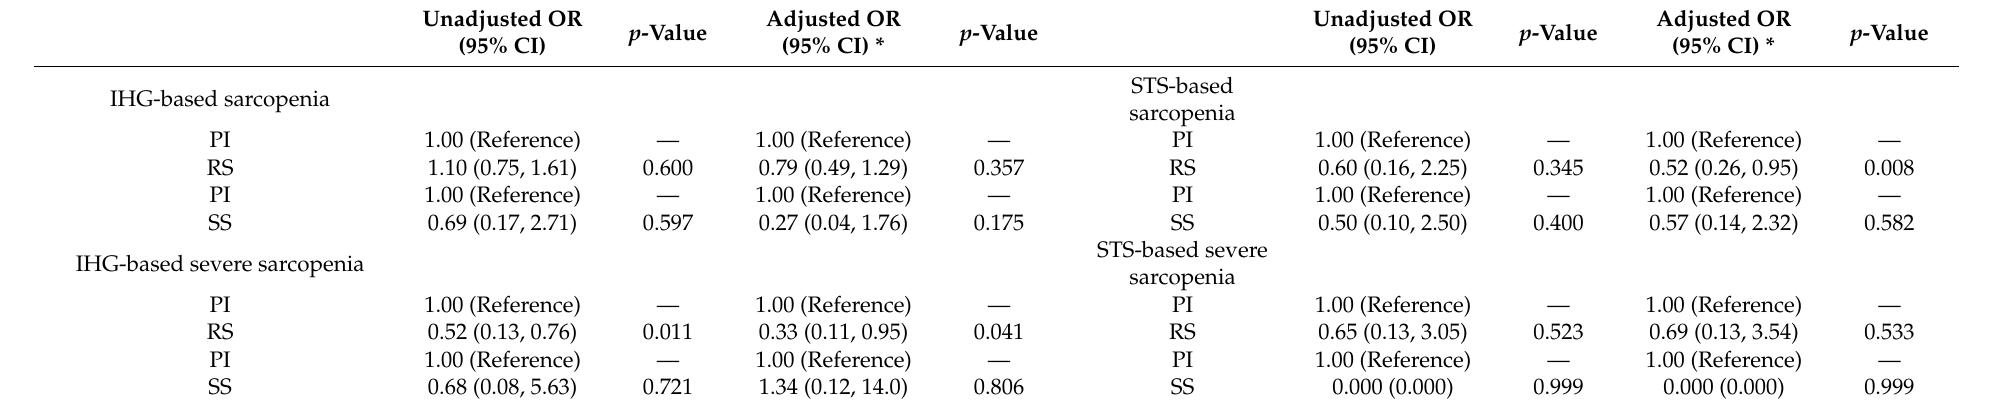
Table 3. Association between training status and sarcopenia in older men ( n =